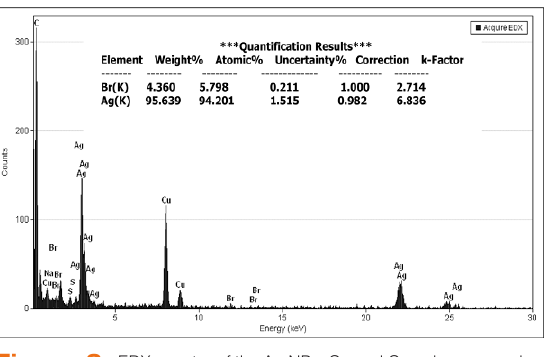
Figure 3. EDX spectra of the Ag NPs, Cu and C peaks appear due to scattering caused by the carbon film and copper